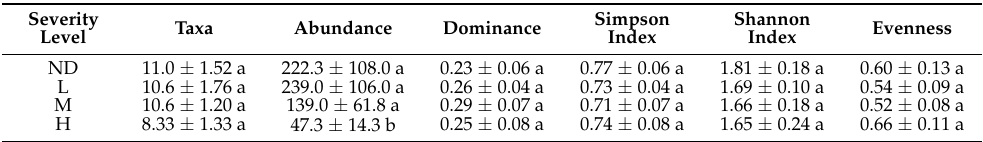
Table 3. Mean ( ± standard error) for diversity and composition structure parameters by fire sever- ity